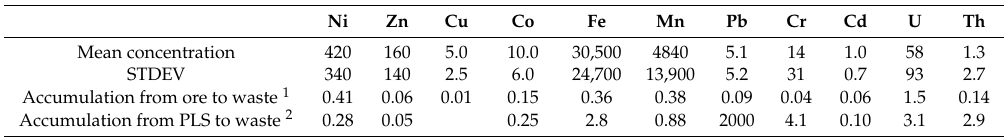
Table 6. Trace element concentrations (ppm) in process waste pond solids. Concentrations are the mean values of four